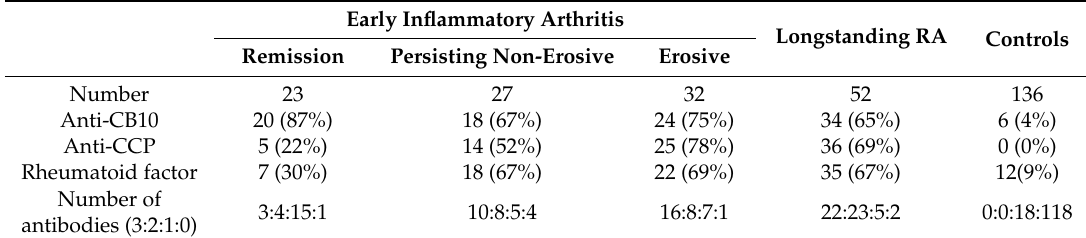
Table 2. Autoantibodies in patients with arthritis and